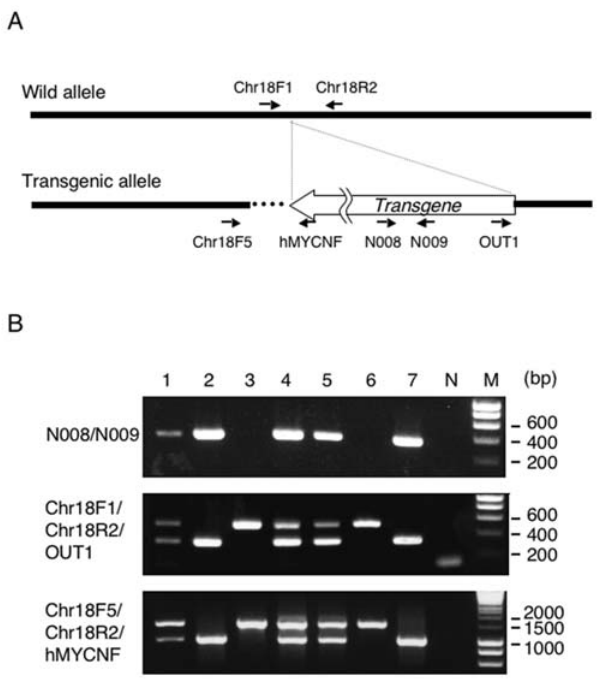
Figure 4. Genotyping PCR using flanking primer sets. (A) The position of primers. Dotted line shows genomic deletion (see results and discussion). (B) PCR with the primers N008/N009 identifies either transgenic or non-transgenic mice, in which the product is detected as 400 bp band. On the other hand, multiple PCR with three primer sets clearly distinguish wild-type (single larger band), homozygous (single smaller band) and hemizygous (both bands) DNA. The expected size of PCR products are 500 bp and 295 bp with Chr18F1/Chr18R2/OUT1, and 1.5 kb and 1 kb with Chr18F5/R2/R3.